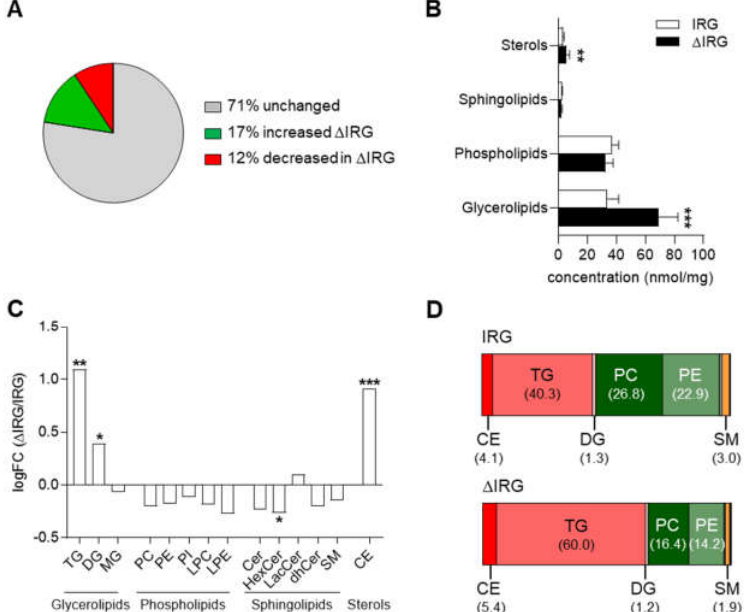
Figure 2. Mice with impaired lipophagy accumulate more glycerolipids and sterols in the liver. ( A ) Percentage of significantly regulated lipid species in ∆ IRG and IRG mice. ( B ) Concentration of glycerolipids, phospholipids, sphingolipids and sterols in IRG and ∆ IRG mice. ( C ) Concentration of lipid classes in ∆ IRG vs. IRG mice shown as logFC. ( D ) Relative abundance of major lipid classes in IRG (top) and ∆ IRG (bottom) mice. Data are shown as means ± SD and analyzed by unpaired t -test with Welch’s correction or one sample t -test vs. 0. * p < 0.05; ** p < 0.01; *** p < 0.001. IRG, n = 7; ∆ IRG, n =